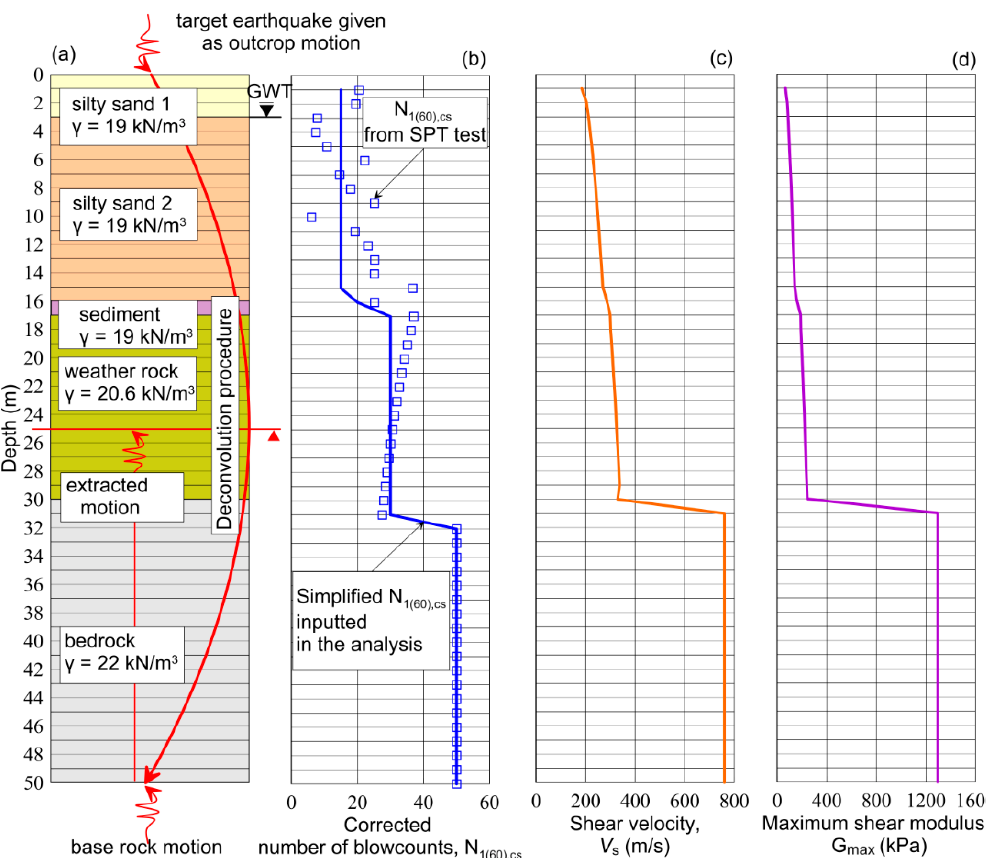
Figure 12. One-dimensional analysis considering deconvolution procedure at Youngil-man port conducted in PROSHAKE: (a) soil layers and its distribution, (b) standard penetration test (SPT) profile, (c) shear velocity ( V s ) profile, and (d) maximum shear modulus ( G max ) profile along the depth. Appl. Sci. 2020 , 10 , x FOR PEER REVIEW